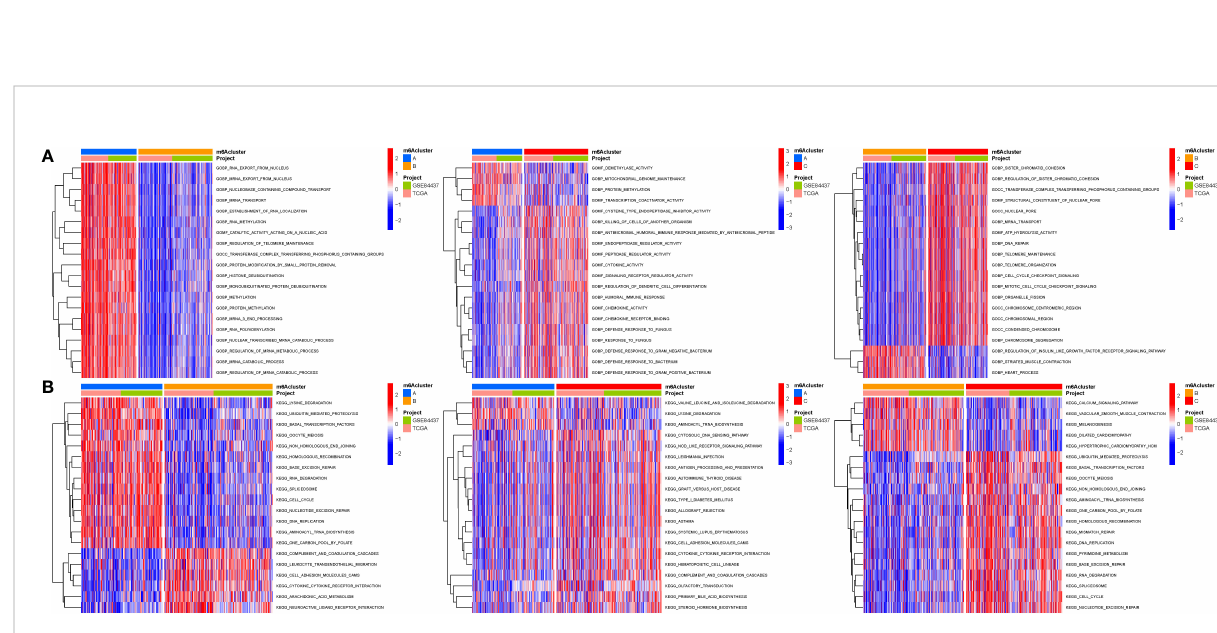
FIGURE 4 GSEA. (A) GO. (B) KEGG. These genes were associated with RNA and